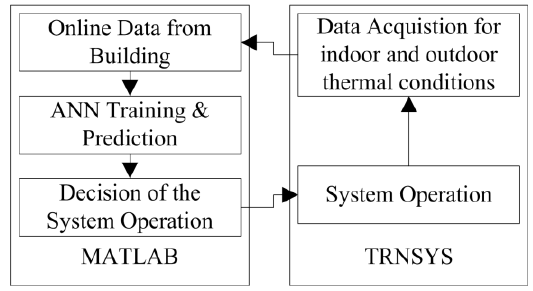
Figure 7. Flow of algorithm operation.